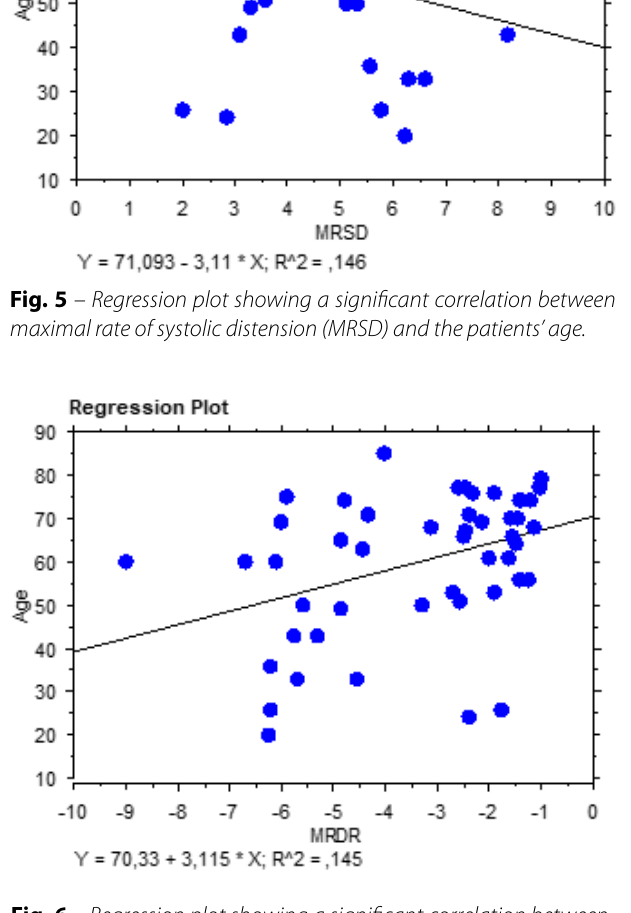
Fig. 6 – Regression plot showing a significant correlation between maximal rate of diastolic recoil (MRDR) and the patients’ age.